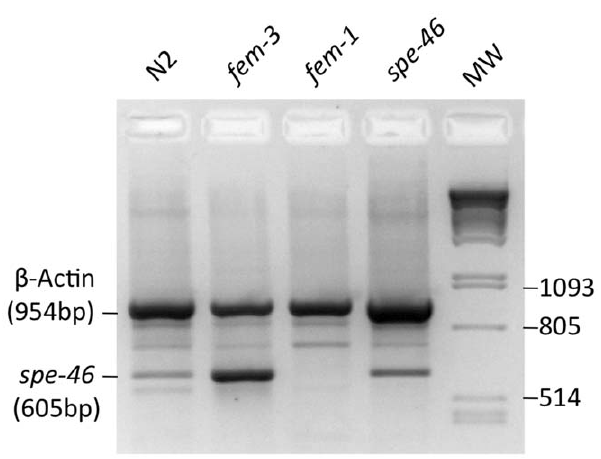
Figure 4. Products of RT-PCR reactions using RNA from wild- type (N2) worms, hermaphrodites that produce only sperm [ fem-3(q23) ], hermaphrodties that produce only oocytes [ fem- 1(hc17) ], and spe-46(hc197) mutant hermaphrodites. The reactions were multiplexed with primers for both the spe-46 transcript and the transcript for the C. elegans b -Actin homolog act-2 . The molecular weight marker (MW) is lambda phage cut with PstI. While non-specific products were amplified, the specific amplicons for both spe-46 and act- 2 were present. In particular, the spe-46 product is present in all lanes but fem-1 , a strain that makes no sperm. The size of each specific amplicon is indicated.